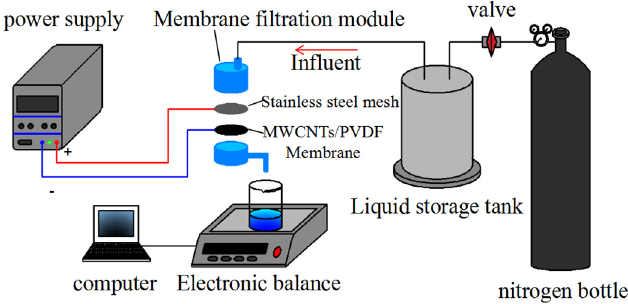
Figure 1. Applied external electric field membrane filtering device.